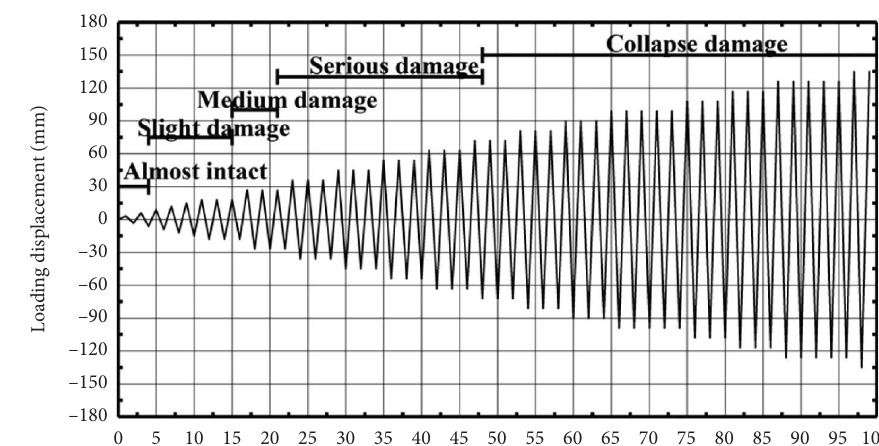
Figure 3: Applied lateral displacement history.